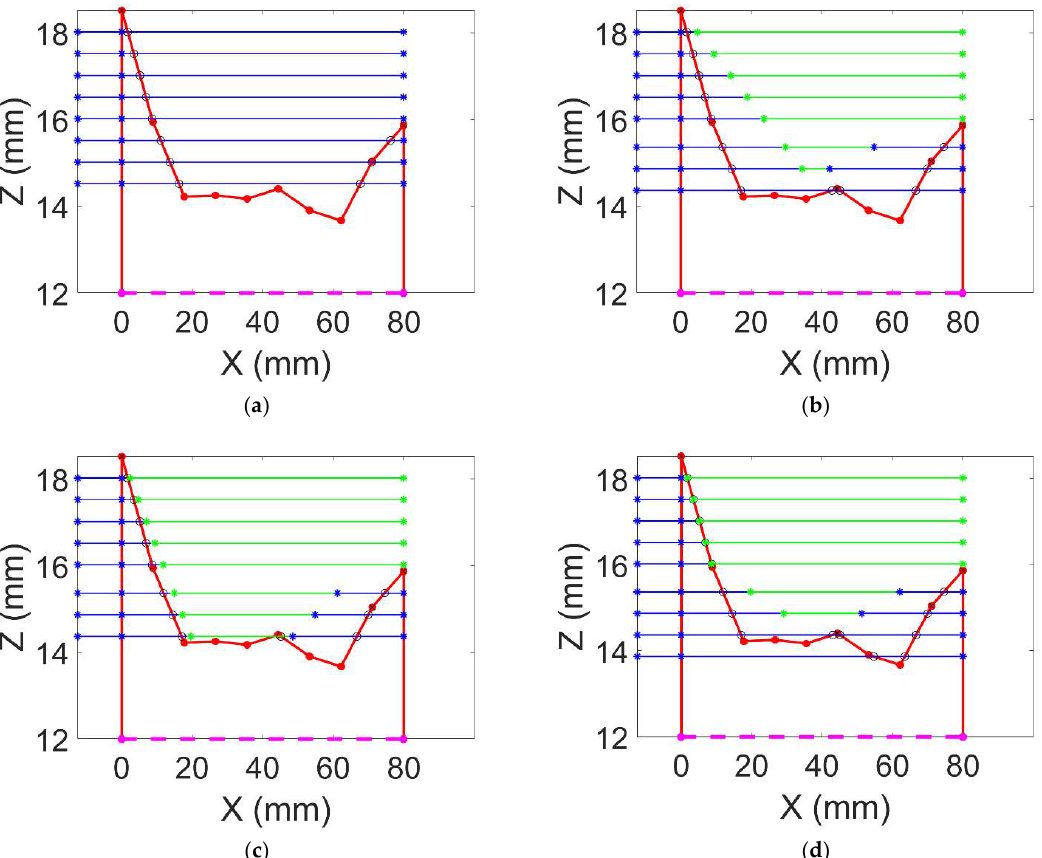
Figure 6. ( a ) Non-optimized subtractive toolpath; ( b ) optimized subtractive toolpath using triangular surface approximation; ( c ) optimized subtractive toolpath using trapezoidal surface approximation; ( d ) optimized subtractive toolpath using hybrid surface approximation. Height profile is shown in red, desired Z height is shown by the dotted pink line. Cut feed segments are indicated by blue lines and rapid feed segments are indicated by green lines.